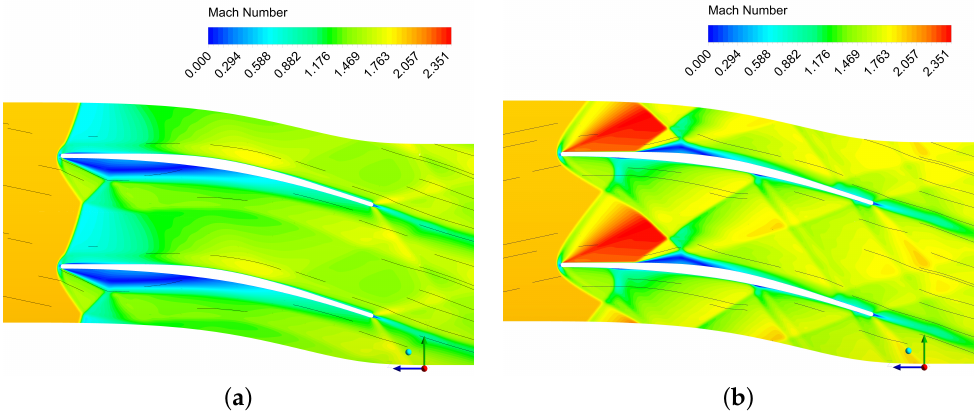
Figure 14. Mach number contours for incidence angle of − 12° ( a ) and incidence angle of +12° ( b